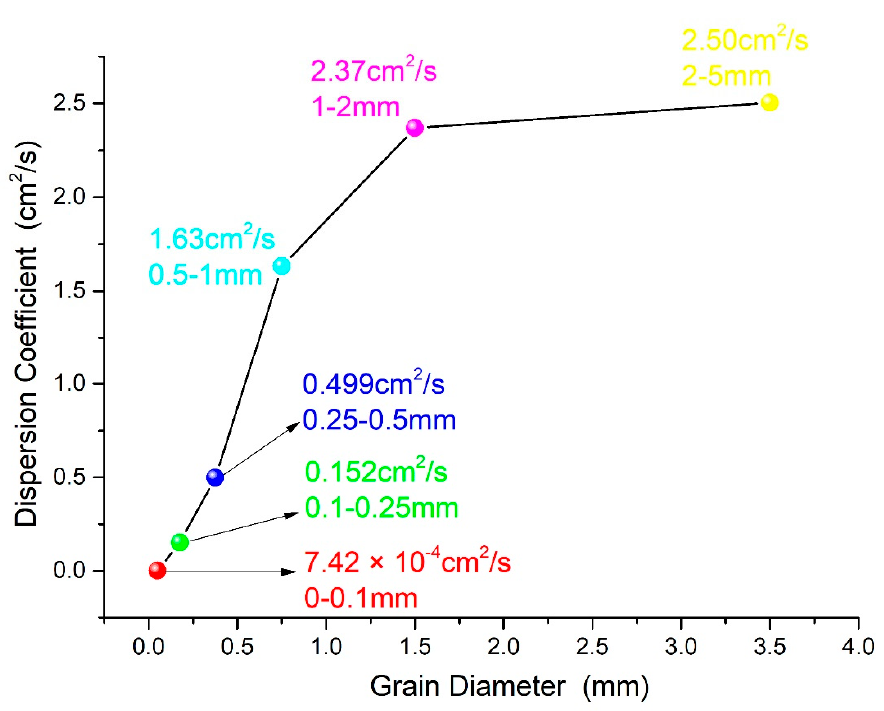
Figure 8. Dispersion coefficients of single-grained soils .